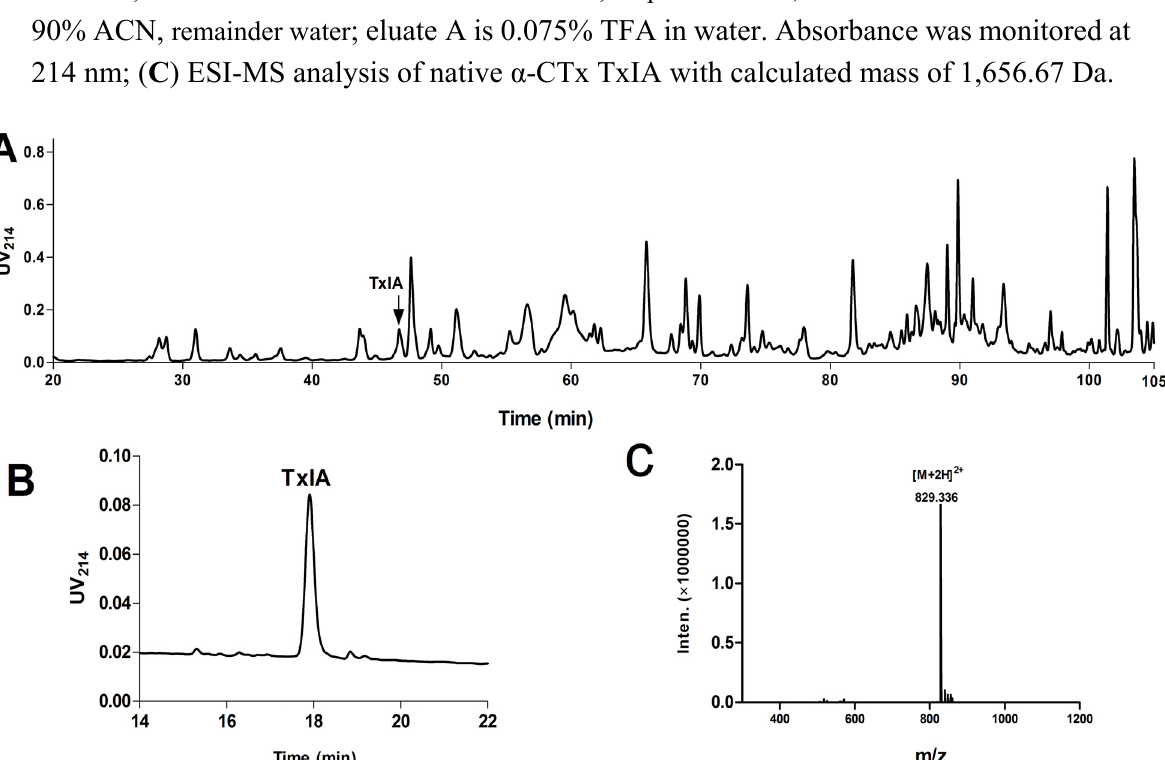
Figure 2. RP - HPLC and ESI-MS analysis of α -CTx TxIA. ( A ) HPLC chromatography of Hainan C. textile crude venom using Vydac C18 semi-preparative column (10 μ m, 10 mm × 250 mm). The arrow denotes α -CTx TxIA.The linear gradient was a 5%–35% solvent B gradient in 75 min, then 35%–65% gradient in 35 min. ( B ) Analytical HPLC profile of native α -CTx TxIA from C. textile venom using a linear gradient of a 10%–30% eluate B, and 90%–70% eluate A over 30 min, In panel A & B, eluate B is 0.05% TFA in 90% ACN, remainder water ; eluate A is 0.075% TFA in water. Absorbance was monitored